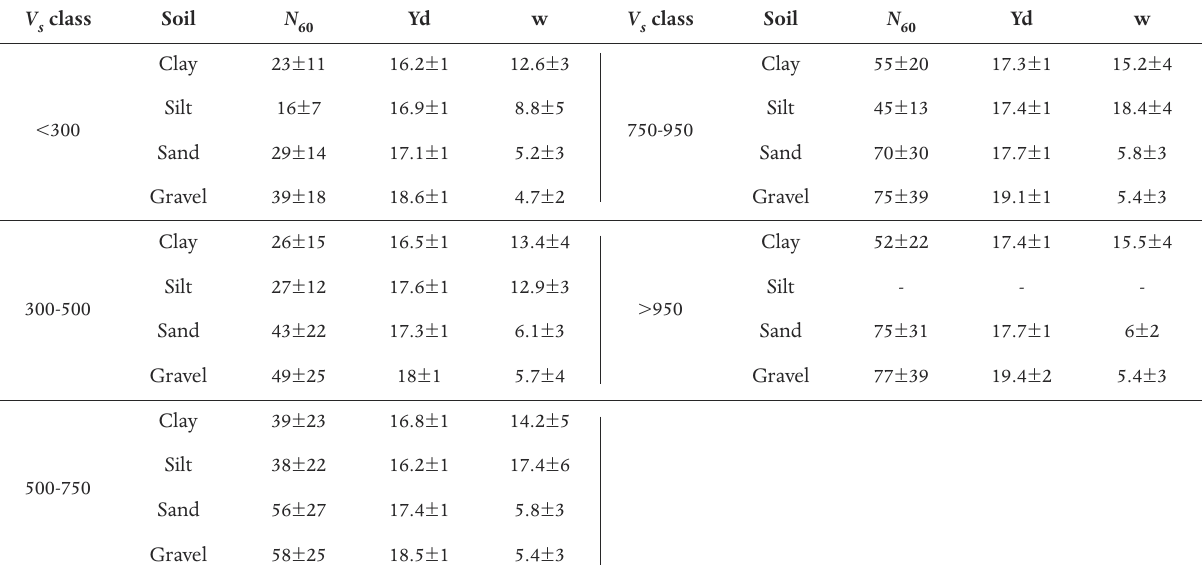
class is shear wave velocity in m/s N is SPT-N value corrected for en- s 60